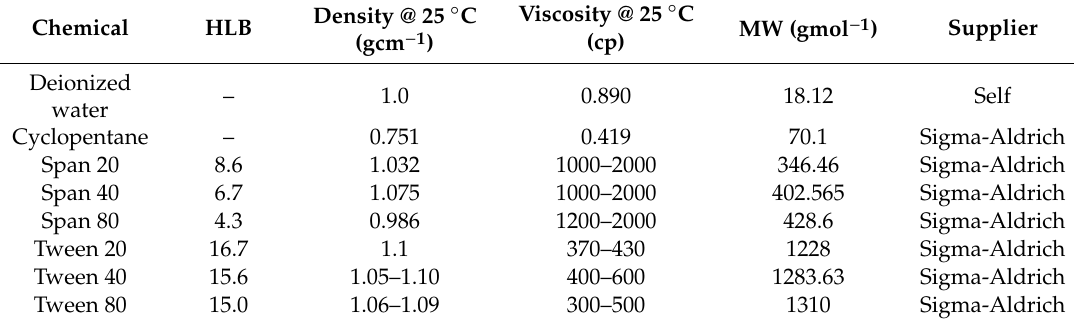
Table 1. List of chemicals used in this